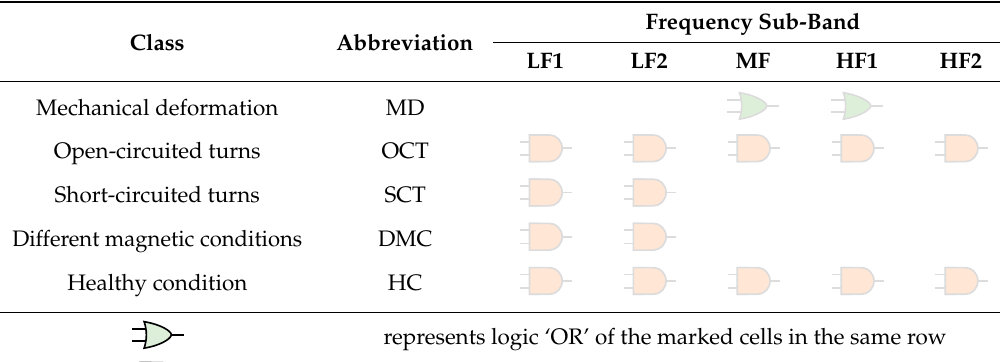
Table 1. Classes of FR data and characteristically affected sub-bands.